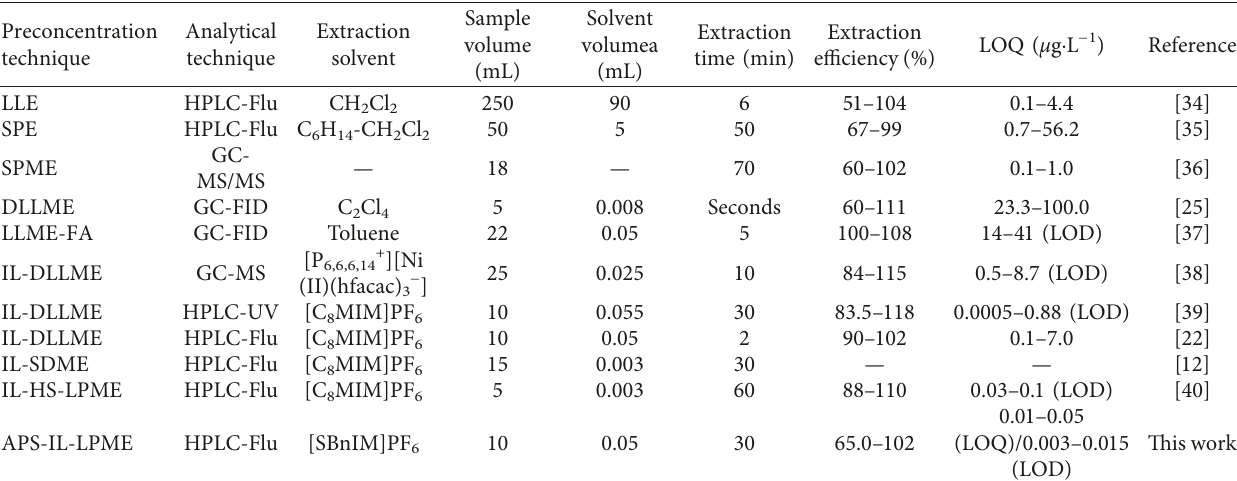
—, not required or not available. a The volume of extraction solvent needed in the extraction process.